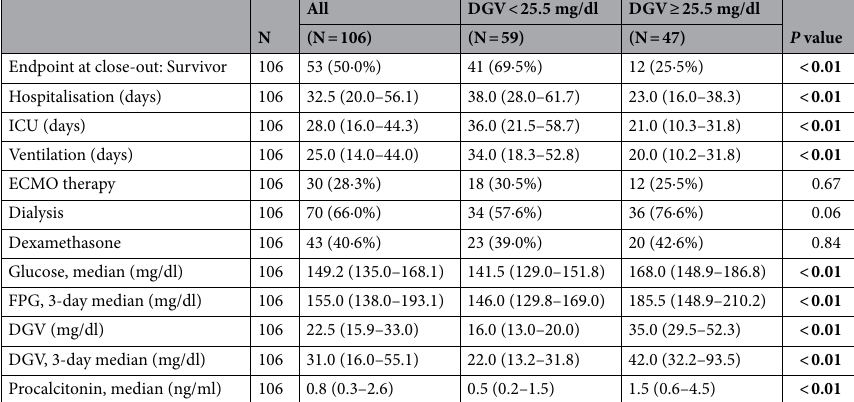
Table 2. Outcome parameters of patients admitted with COVID-19 and ARDS to the Intensive Care Unit. Numerical parameters are expressed as median (IQR) and categorical as N (%). The N column represents the number of non-missing values in each row to the right. P -values for differences between the two groups were tested using Fisher’s exact test for categorical variables and Kruskal–Wallis test for continuous variables. Bold indicates significant differences ( P < 0.05). Parameters denoted with * are calculated over the first three days (“3-day”) or entire course of ICU admission. Daily glycaemic variability (DGV) is explained in the methods